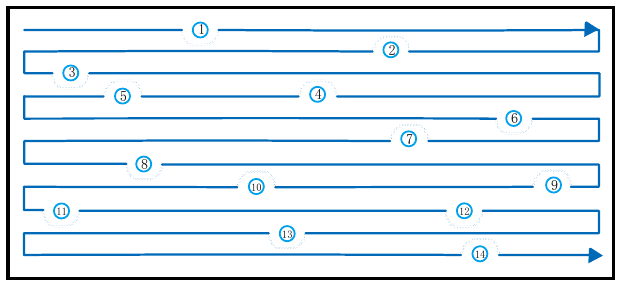
Figure 1. Schematic diagram of missing cells of cleaning robots.